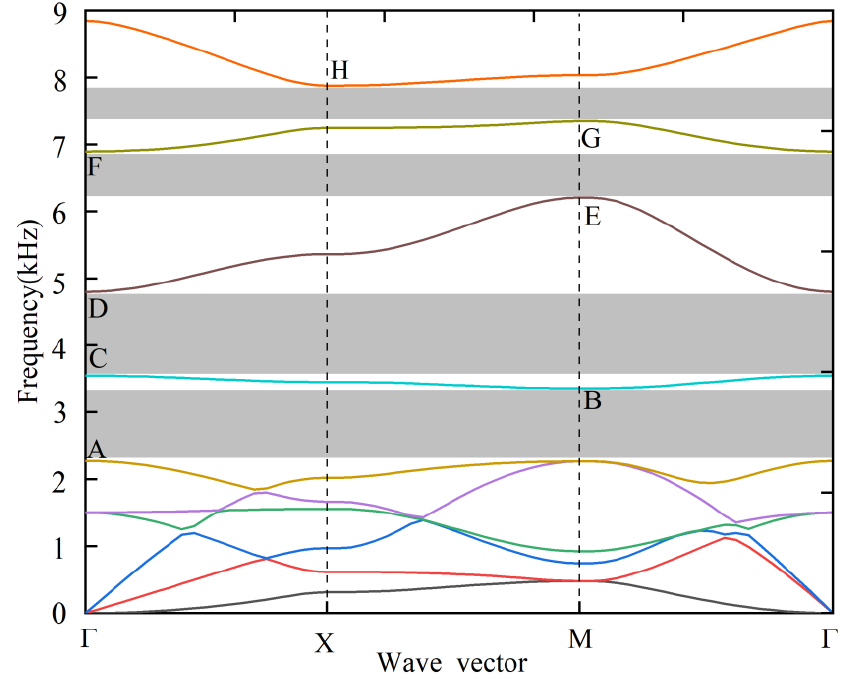
Figure 3. Band structure of the proposed piezoelectric phononic crystal.